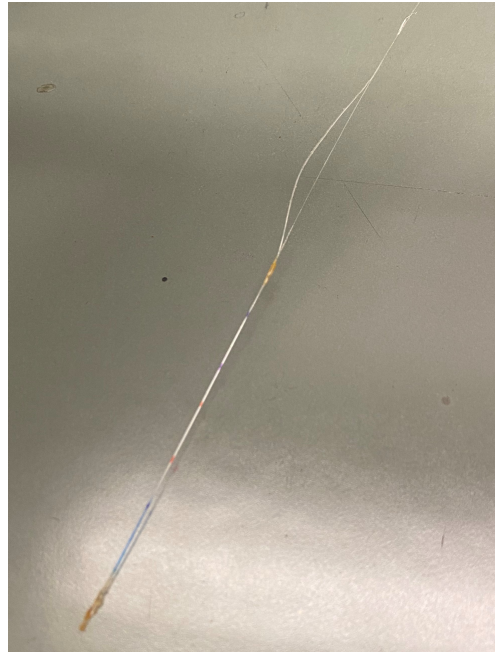
Figure A1. Split fiber (SP4). Coating peeled off the fiber and the adhesive changed color after electrolyte contact (from transparent to amber-colored). Blue and red marks: FBG